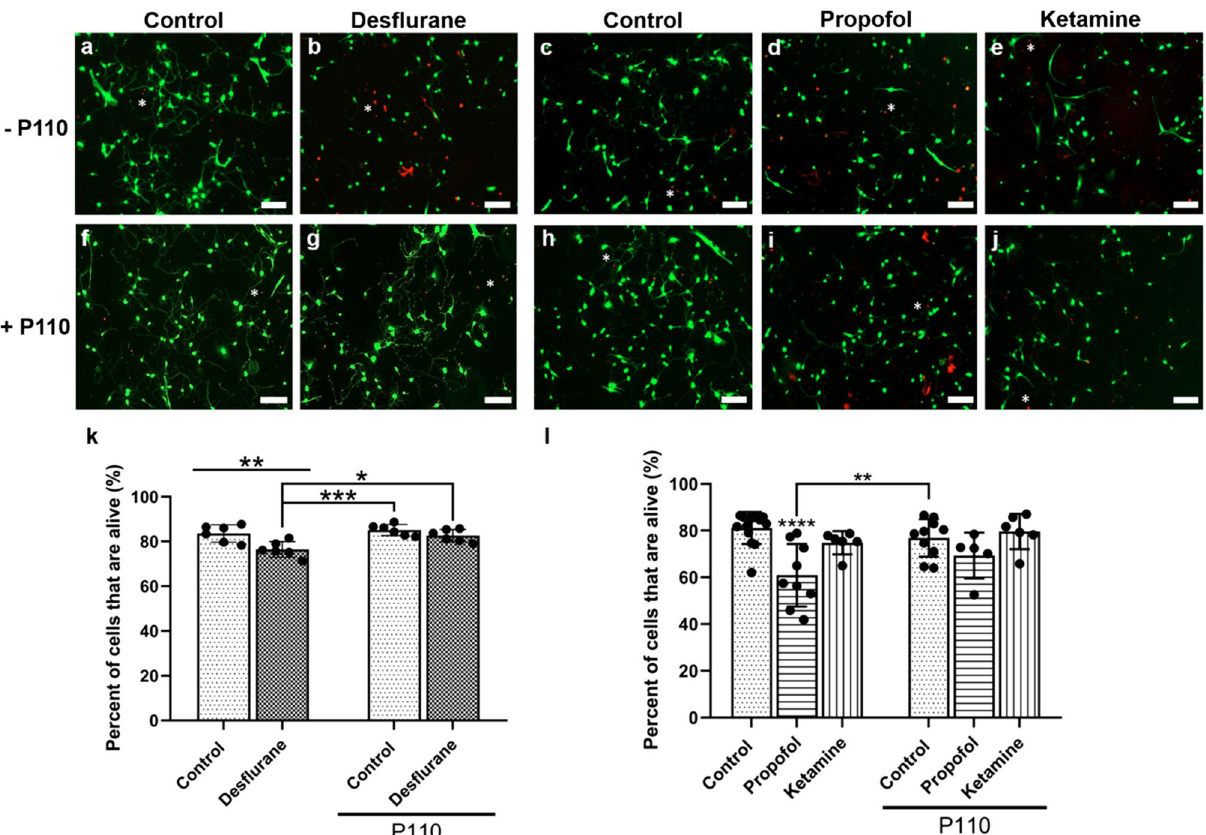
Figure 2. Anesthetics induced cell death in primary cortical neuronal cultures and the synthetic peptide P110 rescued neurons from anesthetic-induced toxicity. Representative live-fluorescent images of different conditions labeled with a LIVE/DEAD Viability/Cytotoxicity Assay where live cells are identified with calcein-AM (green) and dead cells are identified with ethidium homodimer-1 (red) (a–j) . Quantification of percentage of live cells (k–l) . Exposure to 4.3 Vol% desflurane, treatment with 10 µM propofol, but not treatment with 5 µM ketamine caused significant cell death. P110 alone did not affect cellular viability whereas its pre-treatment protected neurons against desflurane. P110 pre-treatment followed by propofol or ketamine did not differ from that of the control. Two-Way ANOVA. * p < 0.05, ** p < 0.01, *** p < 0.001, **** p < 0.0001 as determined by pairwise comparison of post-hoc tests. Bars indicate ± SD measured across biological replicates. Each data-point indicates the mean viability reported in any given biological replicate. Scale bars indicate 100 action affect neurite growth of surviving neurons, we next tested the effects of desflurane, propofol, and keta- mine on the ability of developing neurons to exhibit outgrowth. For this, the cultured neurons were stained with polyclonal antibodies against the 160 kDa fragment of neurofilament (Fig. 3a–j) and average neurite lengths were quantified in multiple areas of 0.15 mm 2 . We found that neurons exposed to 4.3 vol% desflurane exhibited neurite lengths that were not significantly lower than control ( M = 0.70, SD = 0.09 fraction of control, p = 0.0663, n = 3, d = 2.3111) compared to control ( M = 1.00, SD = 0.16, n = 3) (Fig. 3k). Neurons treated with 10 µM propo- fol also showed no significant change in neurite outgrowth ( M = 0.82, SD = 0.05 fraction of control, p = 0.8415, n = 3, d = 1.8276) compared to control ( M = 1.91, SD = 0.36 fraction of control, p = 0.0003, n = 3) ( Fig. 3l). Neu- rons treated with ketamine however, exhibited more robust growth than their control counterparts ( M = 1.91, SD = 0.36 fraction of control, p < 0.0001, n = 3, d = 3.3623) and compared to those treated with propofol alone ( p < 0.0001) (Fig. 3l). Taken together, these data demonstrate that neither desflurane nor propofol inhibit average neurite outgrowth length per cell, whereas ketamine enhances neuronal outgrowth of cortical neurons. Synaptic network assembly. Robust synaptic network assembly is prerequisite to proper brain development. To examine the effects of various anesthetics on synaptic network assembly, cells were stained for two synaptic proteins—synaptophysin, a presynaptic vesicle protein, and postsynaptic density protein (PSD-95); their expres- sion patterns and colocalized juxtapositions were taken as an index of synaptic specialization (Figure S3). Only puncta that met these requirements were counted as synapses, such as the example highlighted in Figure S3. Instances where there was only synaptophysin signal (examples indicated with an arrow in Figure S3a), or only PSD-95 signal (examples indicated with an asterisk in Figure S3a) with no juxtaposition to each other and no overlapping yellow signal were not considered as the indicators of a synapse. Neurons exhibiting juxtaposition of PSD-95 (green) with synaptophysin puncta (red) were deemed as ‘synapses’ (Fig. 4a–h). Desflurane-exposed